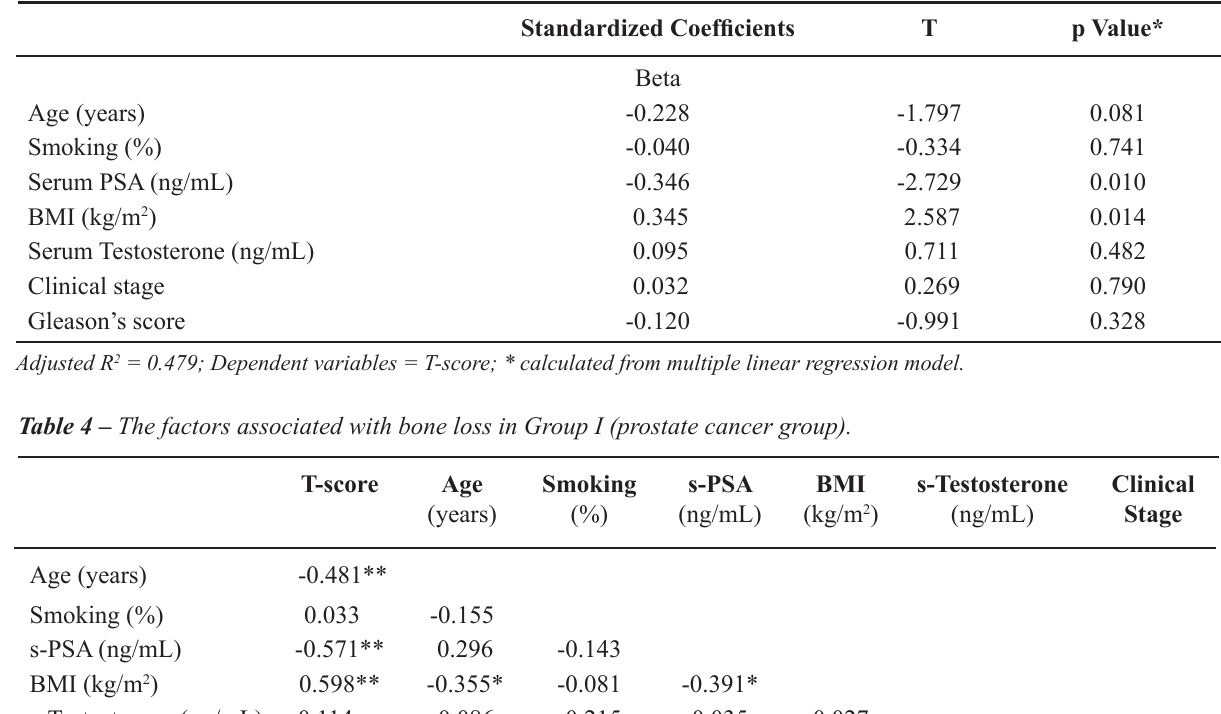
Table 3 – The factor associated with bone loss in Group I (prostate cancer).